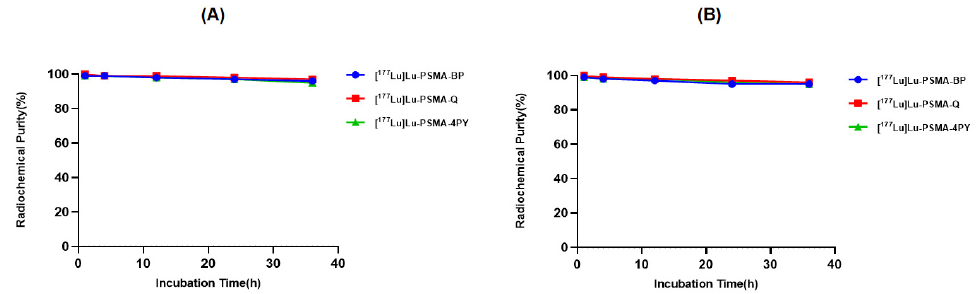
Figure 2. In vitro stability of [ 177 Lu]Lu-PSMA-R in PBS ( A ) and BSA ( B ).